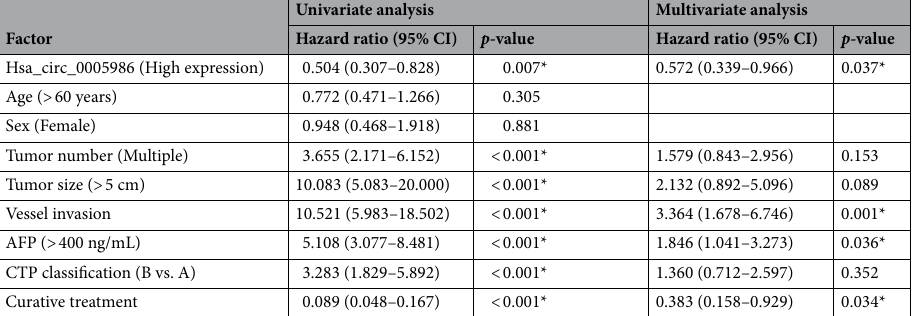
Table 3. Prognostic factors for overall survival in univariate and multivariate analyses. CI confidence interval; AFP alpha-fetoprotein; CTP Child–Turcotte–Pugh. * p <